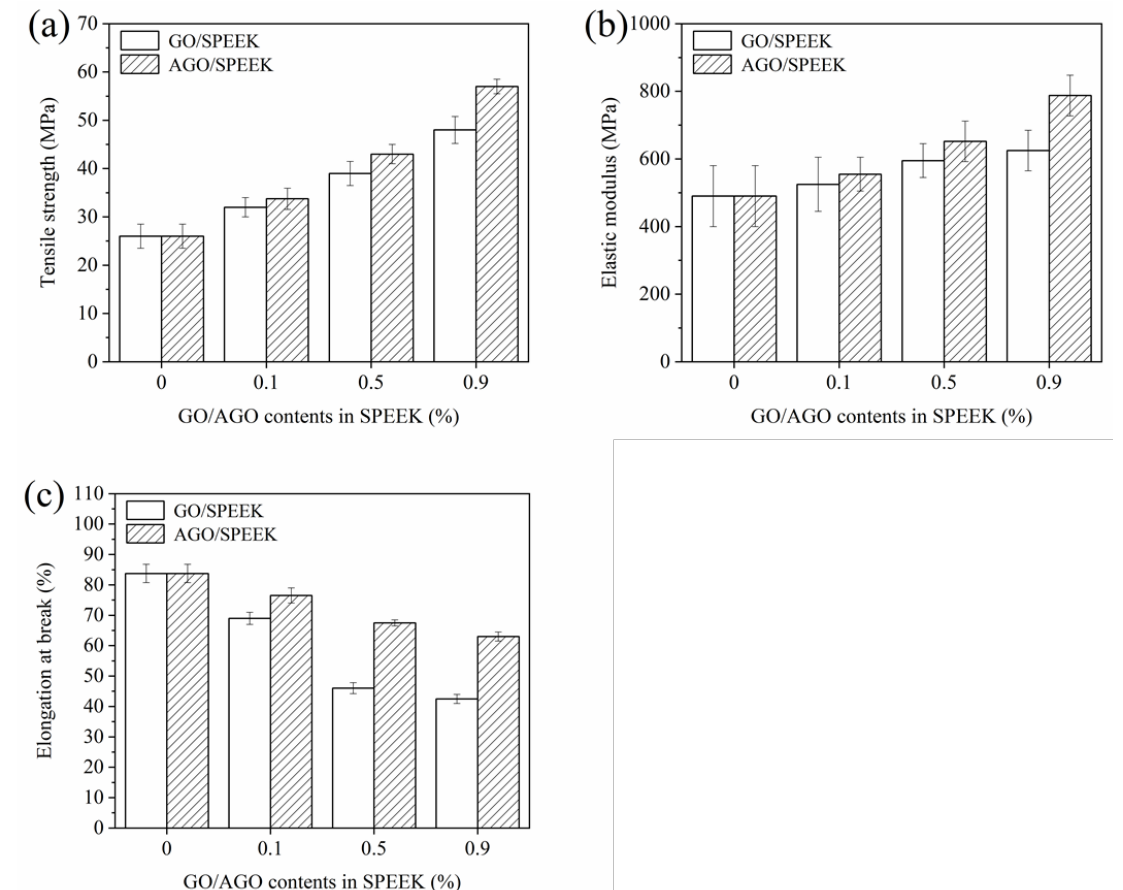
Figure 3. Mechanical properties of AGO/SPEEK films. ( a ) Tensile strength, ( b ) elastic modulus, ( c ) elongation at break.